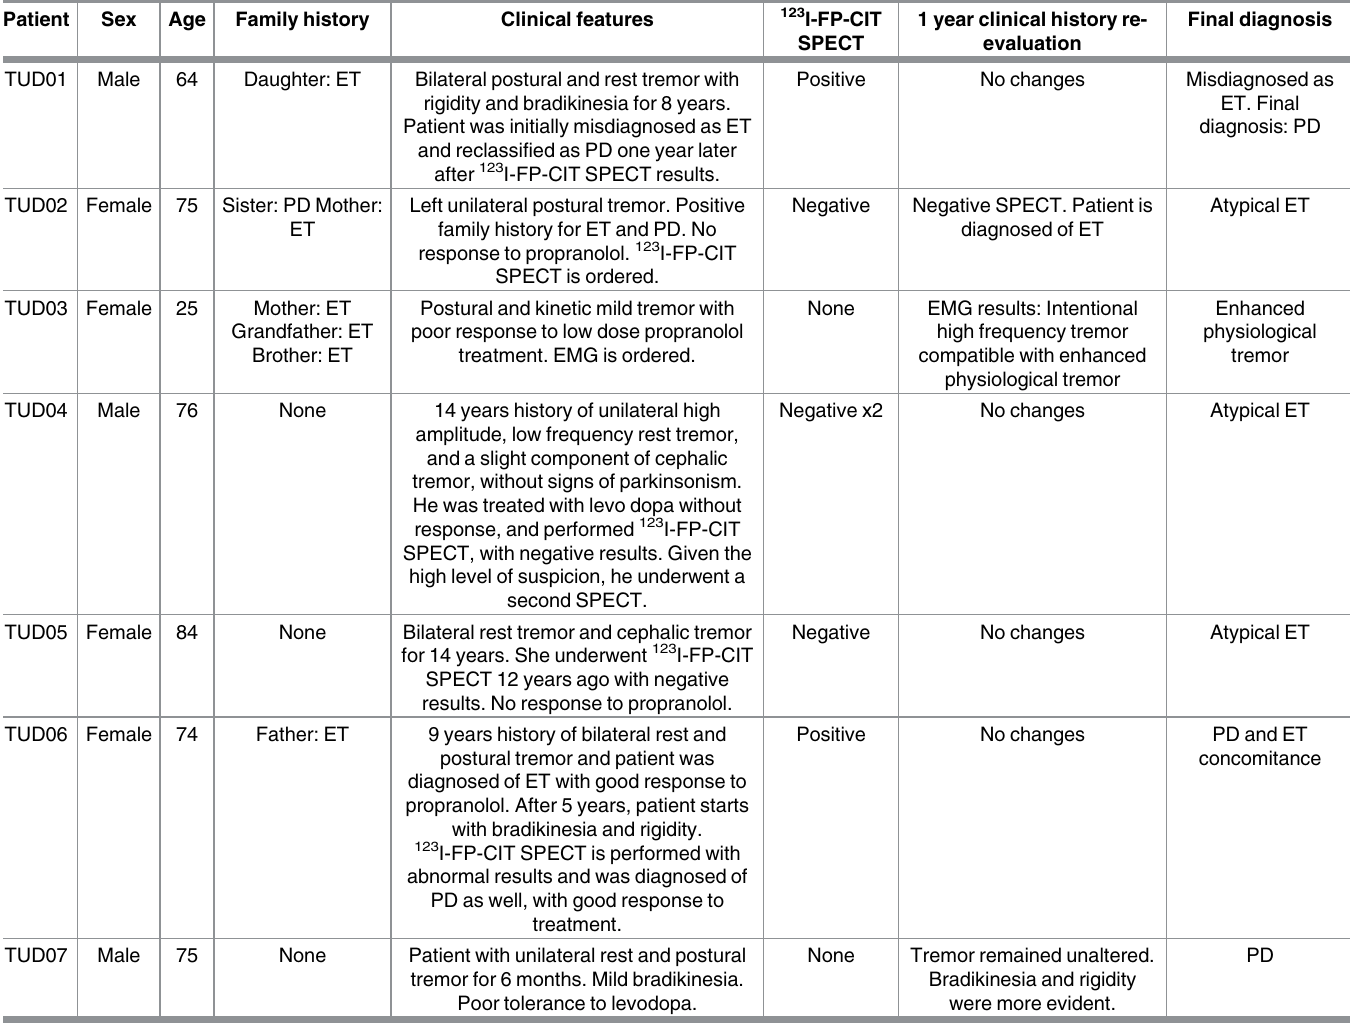
Table 2. Patients with tremor of undecided diagnosis